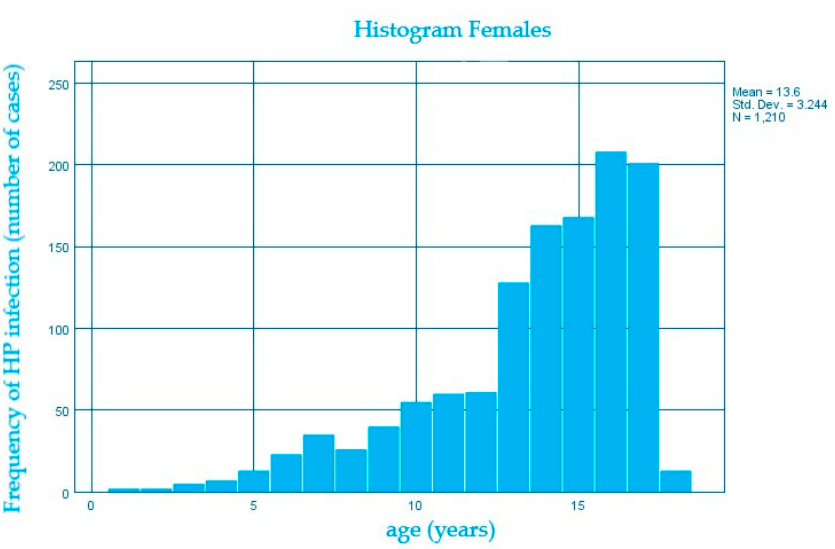
Figure 4. Distribution of H. pylori infection (number of cases) according to age (years) in females.